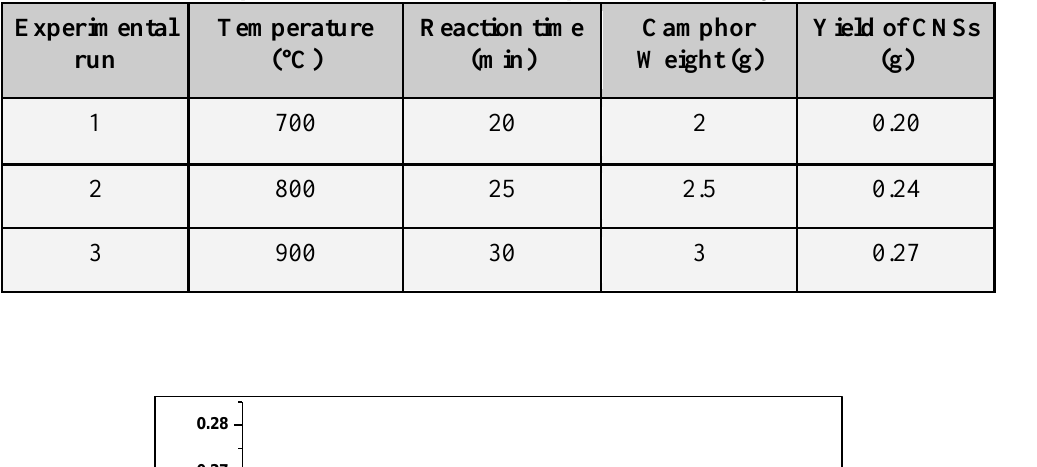
Table 1: Experimental condition and response for CNSs synthesized.